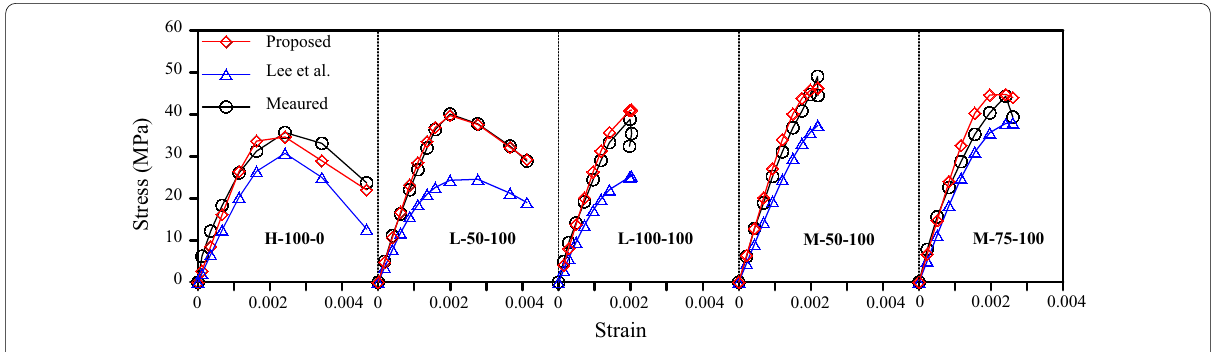
Fig. 8 Stress–strain curves of LWAC‑BA.